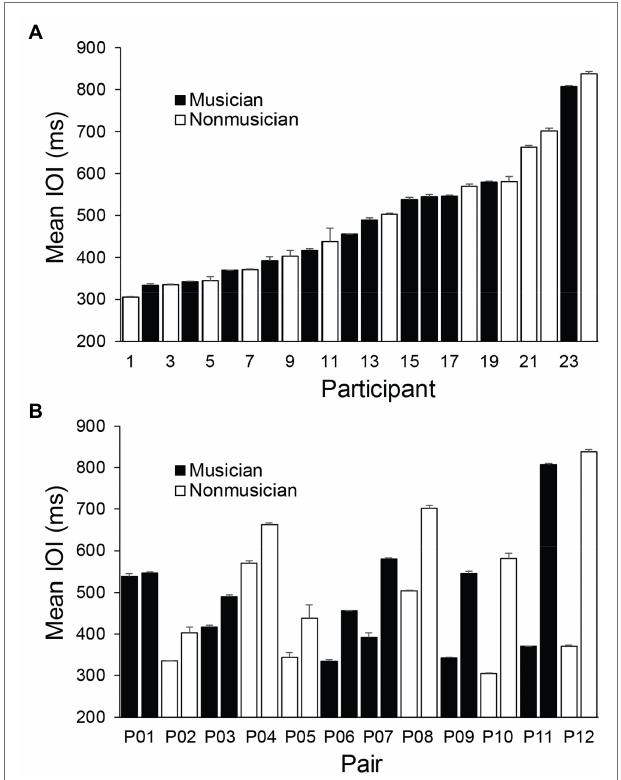
FIGURE 2 | Mean individual Spontaneous Production Rates. Error bars indicate standard errors of the mean. (A) Participants ordered by fastest SPR to slowest. (B) Pairs ordered by smallest difference between partners’ SPRs to the largest difference.